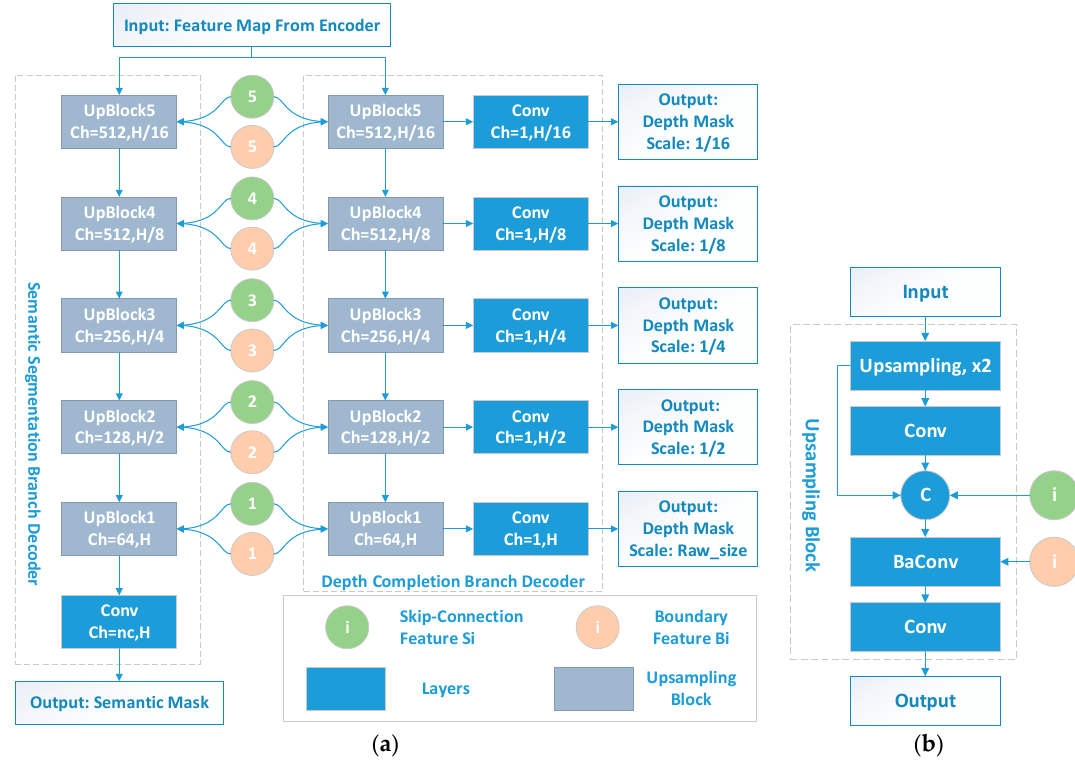
Figure 3. Semantic segmentation and depth completion decoder ( a ) and UpBlock structure ( b ). nc represents the number of semantic classes. BaConv refers to the boundary-aware convolution [20]. The bilinear interpolation upsampling layer is used in (b) as Upsampling, x2.